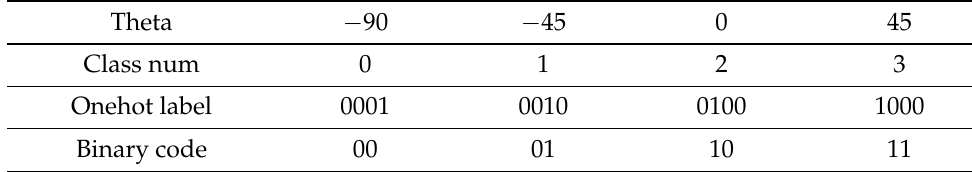
Table 1. Binary coded annotation